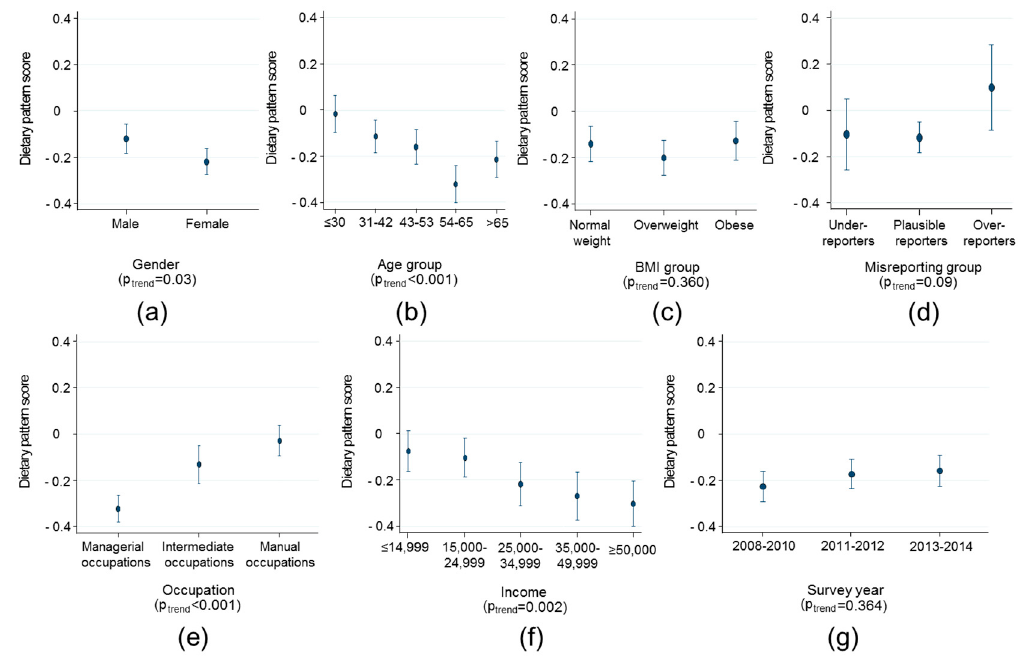
Figure 3. Trends in the obesogenic dietary pattern score among adults (>18 years) by ( a ) sex; ( b ) age; ( c ) weight status; ( d ) energy reporting status; ( e ) occupation; ( f ) household income; and ( g ) survey year. Figures present marginal means and tests for trend with survey-weighted linear regression adjusted for age, gender and daily energy intake.